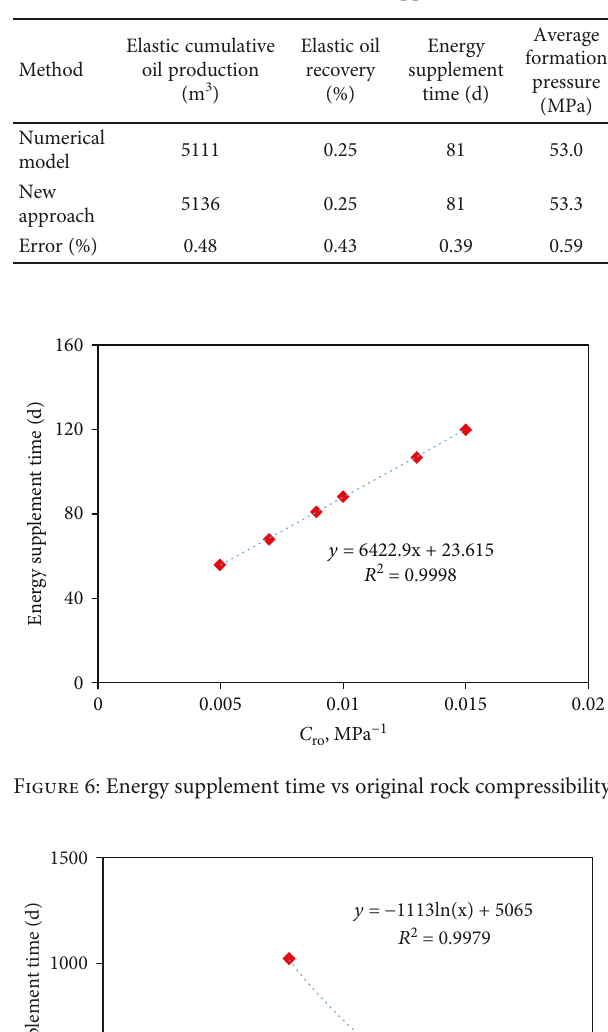
Table 3: Error of the new approach.